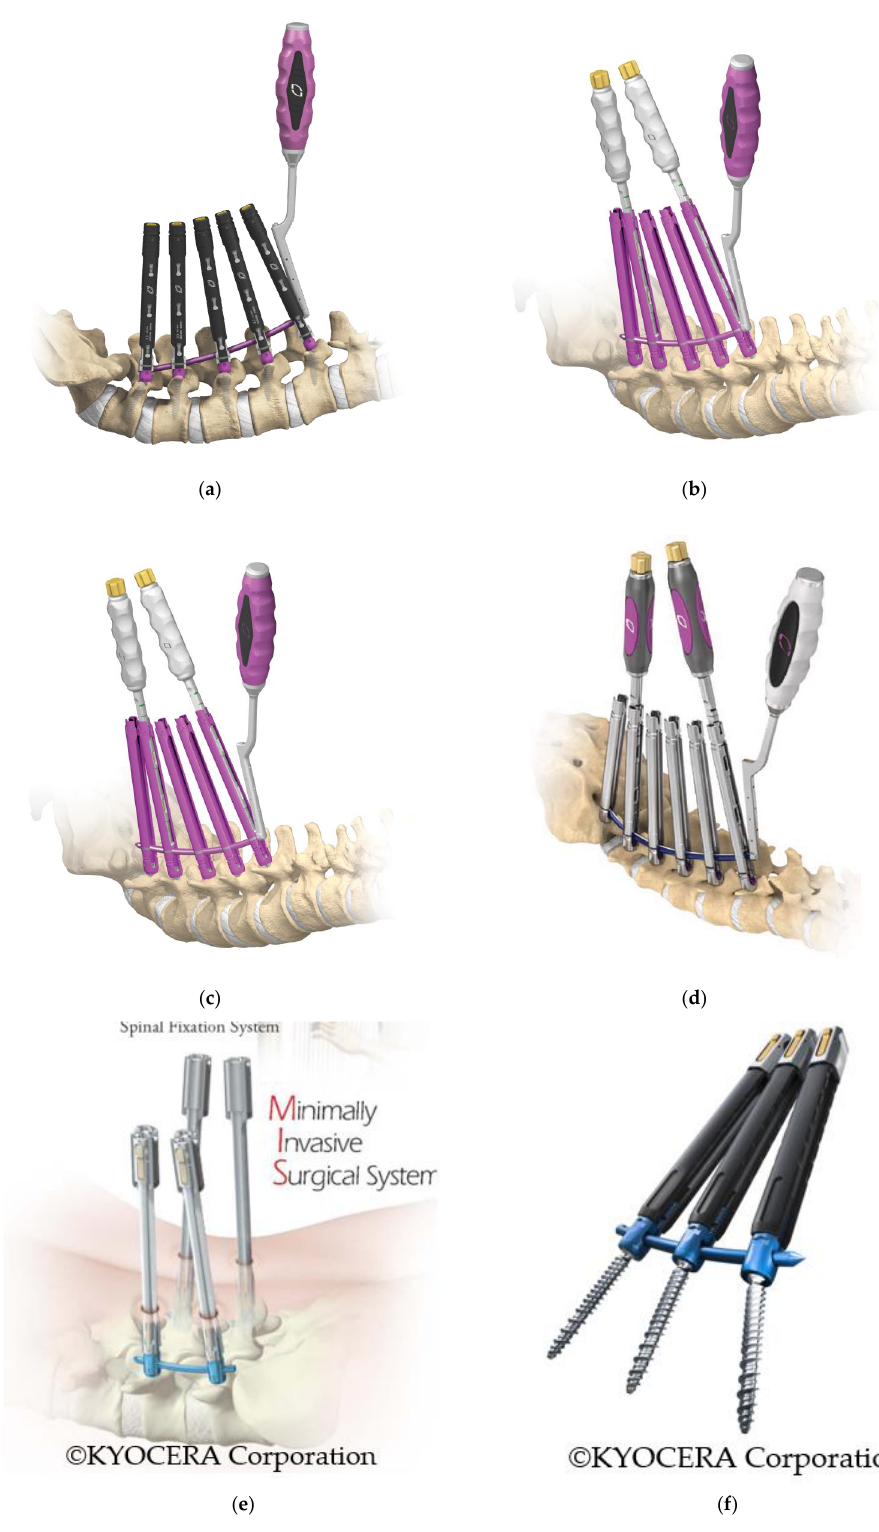
Figure 3. Third-generation PPS systems (PRECEPT ® , RELINE ® , Associa Harp ® , and Associa Zique ® ). PRECEPT ® (extender type) ( a ), PRECEPT ® (tab type) ( b ), RELINE ® (extender type) ( c ) , RELINE ® (tab type) ( d ), Associa Harp ® ( e ), and Associa Zique ® ( f ).